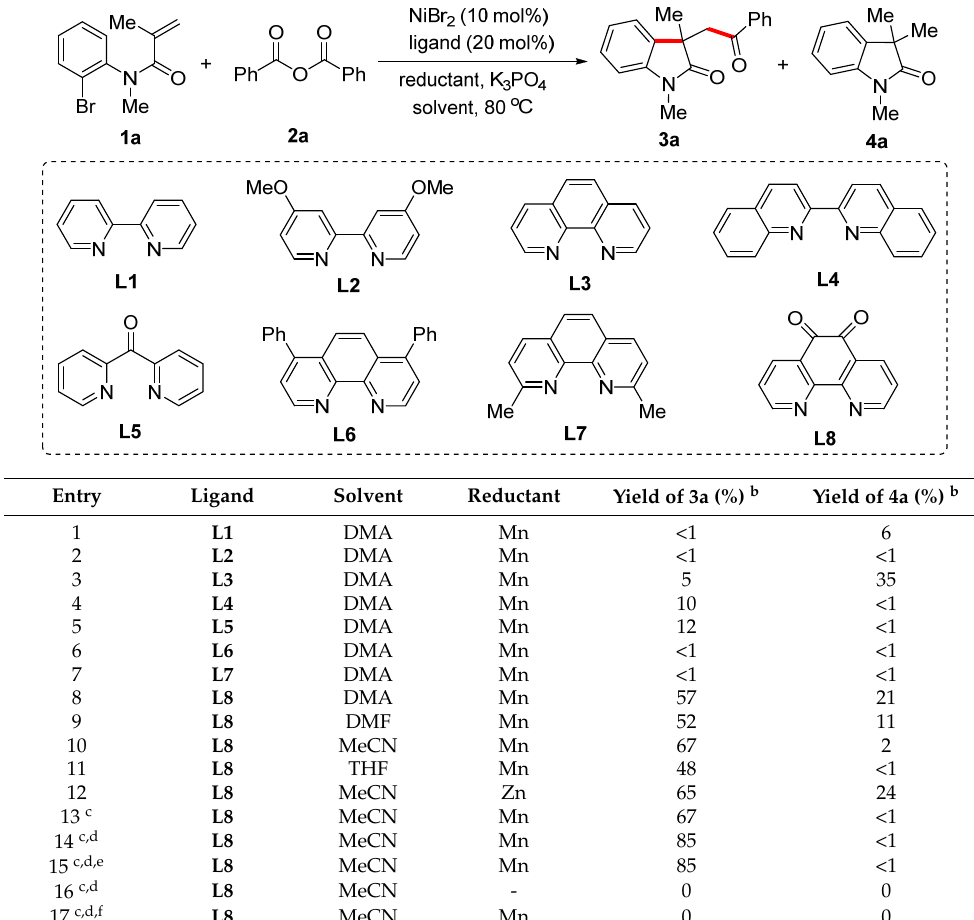
Table 1. Optimization of the reaction conditions a .